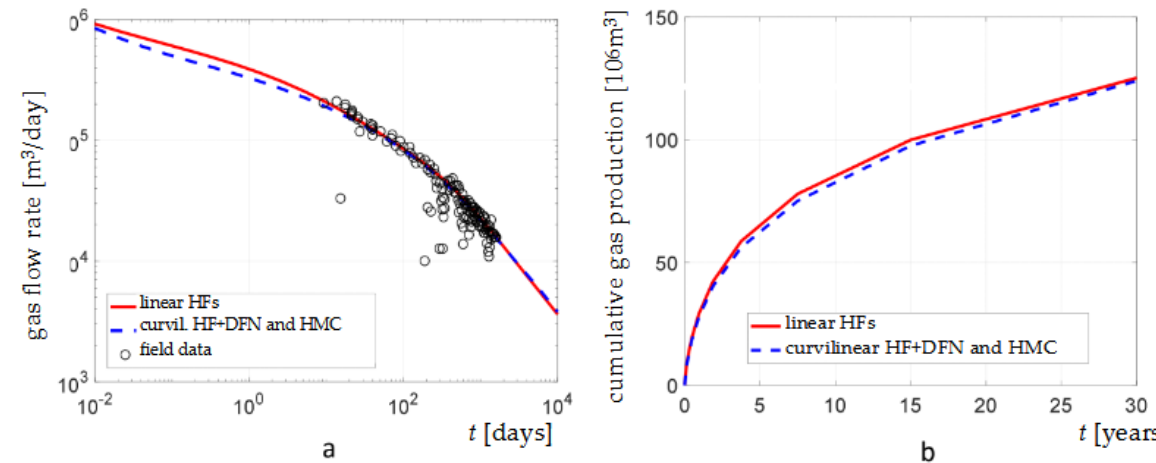
Figure 24. Comparison of gas flow rate ( a ) and cumulative production ( b ) between the scenario with linear HFs and the scenario with curvilinear HFs and DFN and, in addition, consideration of HMC (simulation